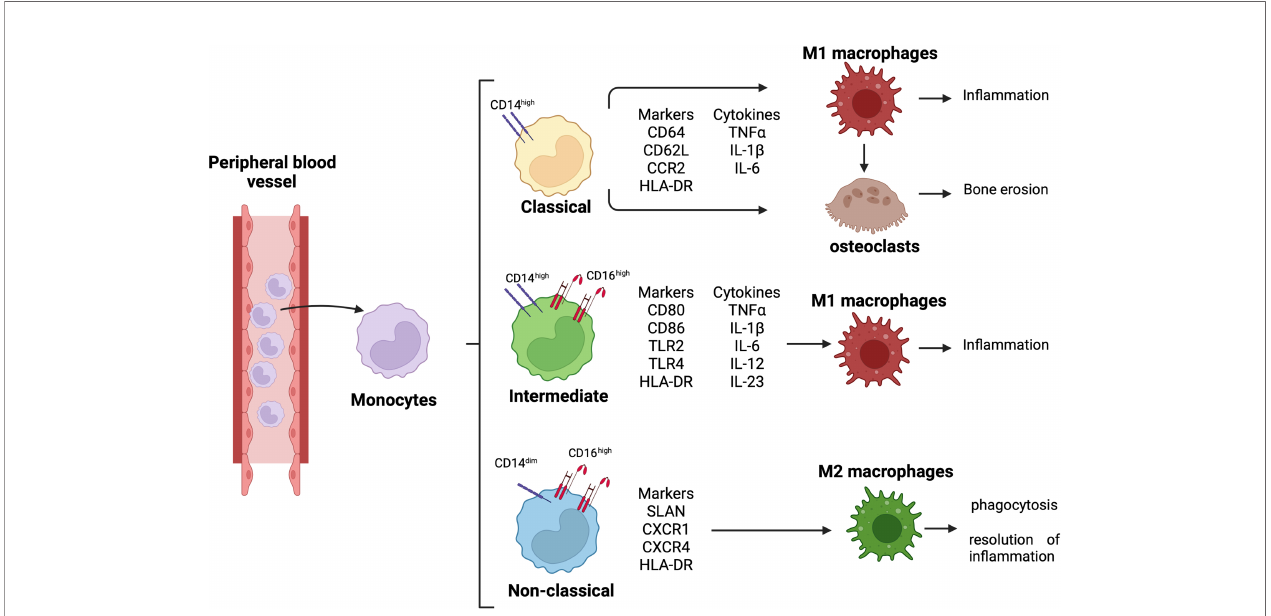
FIGURE 1 | Monocyte differentiation and related role in RA pathogenesis. Differentiation of circulating monocytes in their three subsets, classical (CD14 high ), intermediate (CD14 high CD16 high ), and non-classical (CD14 dim CD16 high ) monocytes. Classical monocytes can differentiate into pro-in fl ammatory macrophages and osteoclasts, contributing to synovial tissue in fl ammation and bone erosion; intermediate monocytes differentiate into pro-in fl ammatory macrophages contributing to tissue in fl ammation; non-classical monocytes differentiate into anti-in fl ammatory macrophages promoting phagocytosis and resolution of in fl